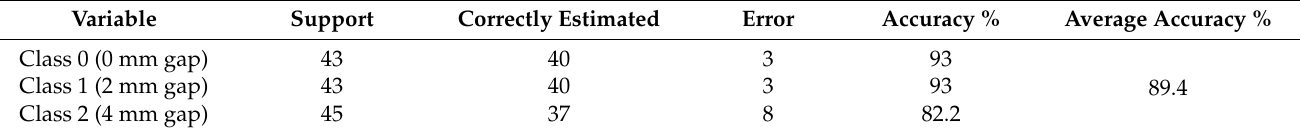
Table 9. Real-time weld gap detection performance of the proposed DNN model (decreasing gap). Variable Support Correctly Estimated